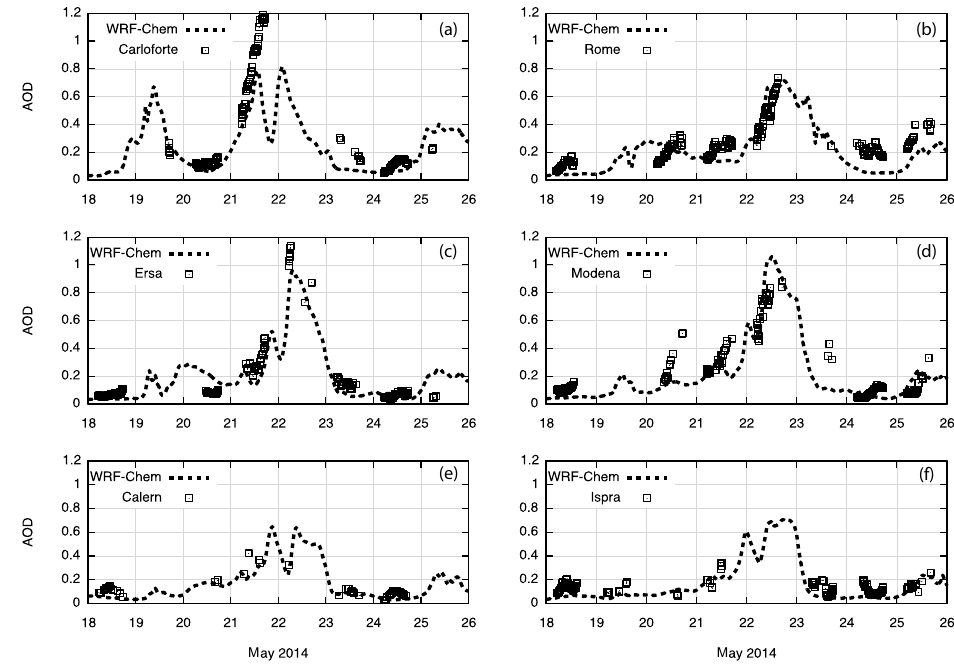
Figure 6. Hourly resolved columnar AOD at 550nm as obtained from the WRF-Chem (S01) simulation (dotted lines) and from AERONET measurements (squares) at the six stations of (a) Carloforte, (b) Rome, (c) Ersa, (d) Modena, (e) Calern, and (f) Ispra (see also Fig. 1).